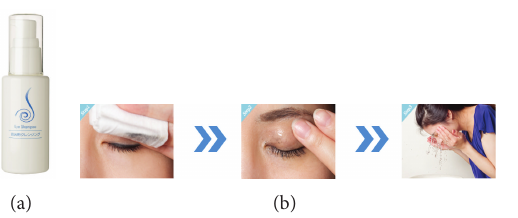
Figure 1: Lid hygiene technique. (a) Eye Shampoo (http://www.eyeshampoo.com/). (b) Lid cleansing using Eye Shampoo.